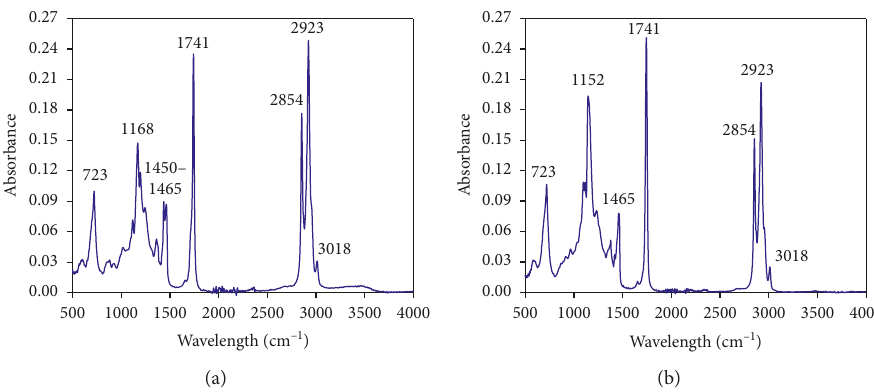
Figure 3: Infrared spectrum of fuels produced: (a) Amazon sailfin catfish biodiesel; (b) Amazon sailfin catfish Table 3: Differences between produced biodiesel and oil according to analyzed regions of the infrared spectrum. Absorbance band (cm − 1 ) Assignment Biodiesel Oil Reference